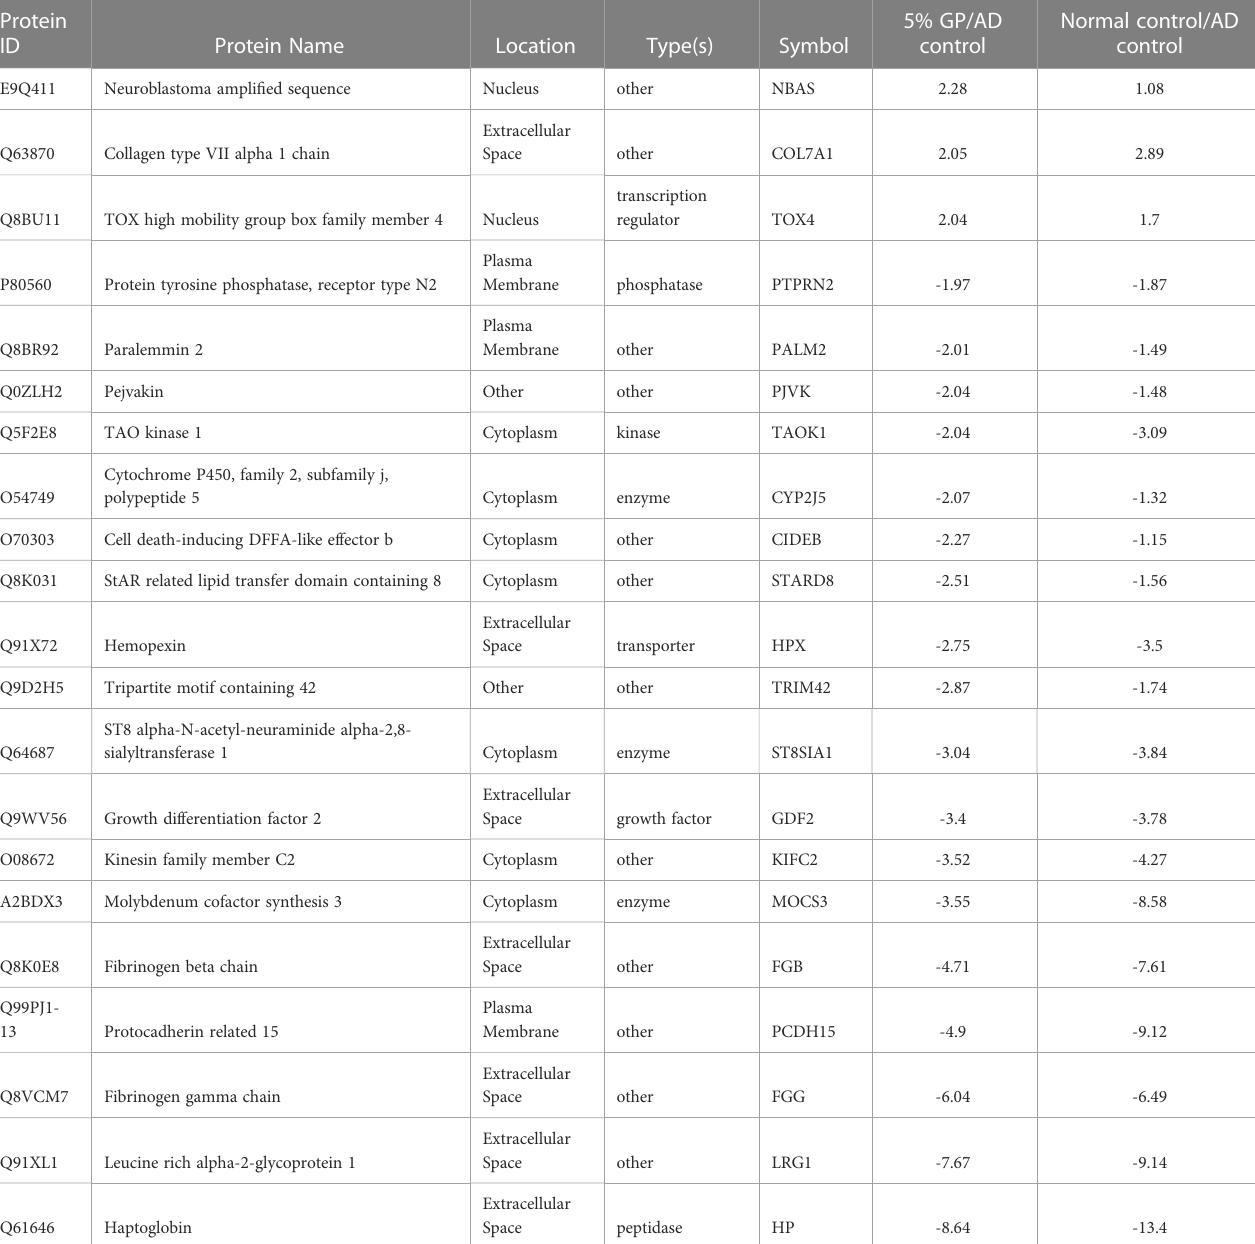
TABLE 2 Grape powder (GP) modulated ( ≥ 2-fold) proteins identi fi ed using quantitative global proteomics analyses. Protein